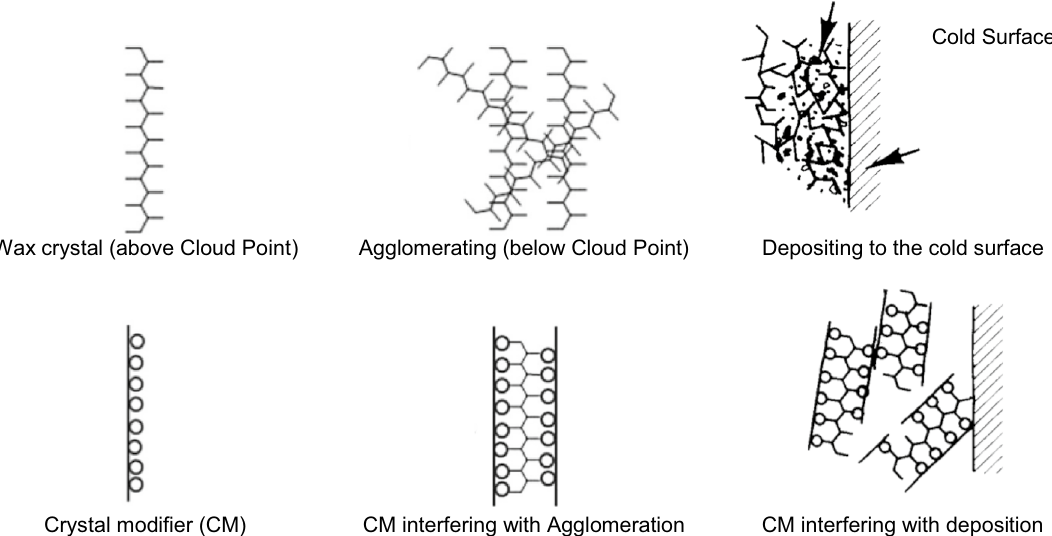
Fig. 1 Schematic representation of wax crystal modifier co-crystallization with wax crystals (Allen and Roberts 1978) cited in (Al-Yaari